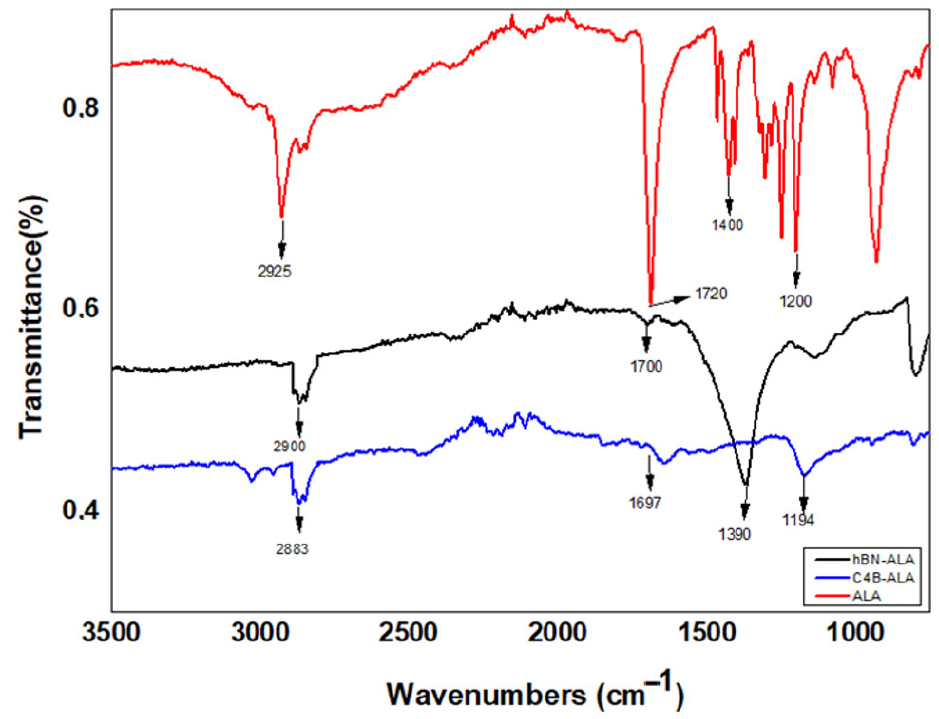
Figure 3. FTIR spectra of hBN-ALA, B 4 C-ALA, and ALA.